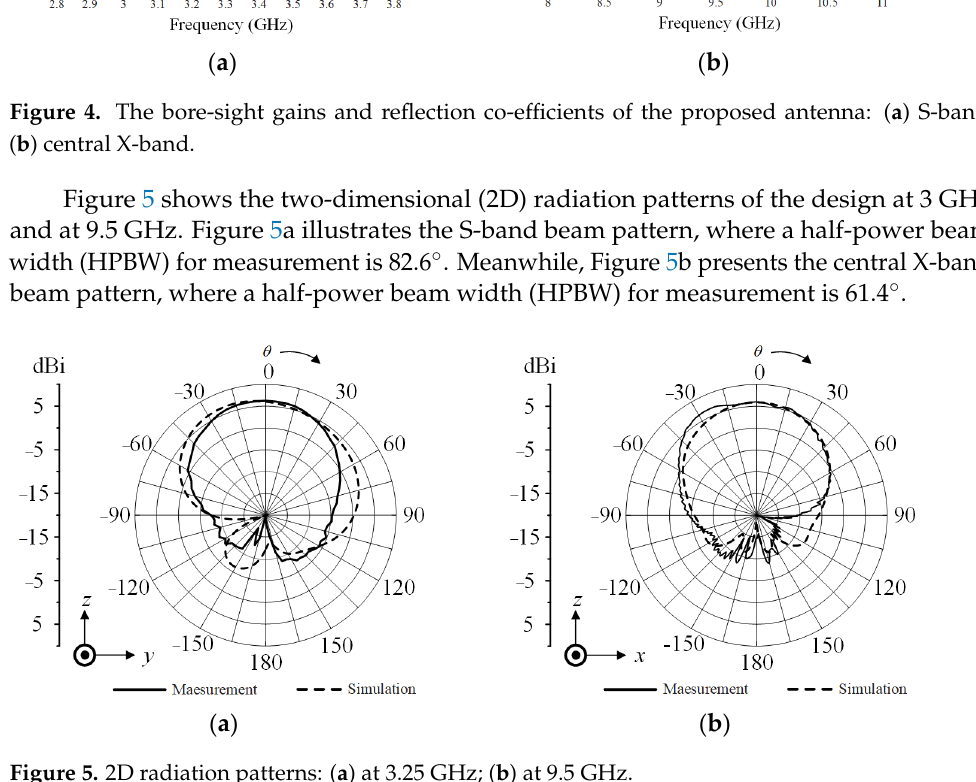
Figure 4. The bore-sight gains and reflection co-efficients of the proposed antenna: ( a ) S-band; ( b ) central X-band.